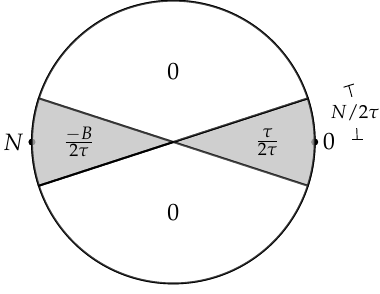
Figure 3. Illustration of the slices for the test vector coefficients of equality test bootstrapping (when τ =